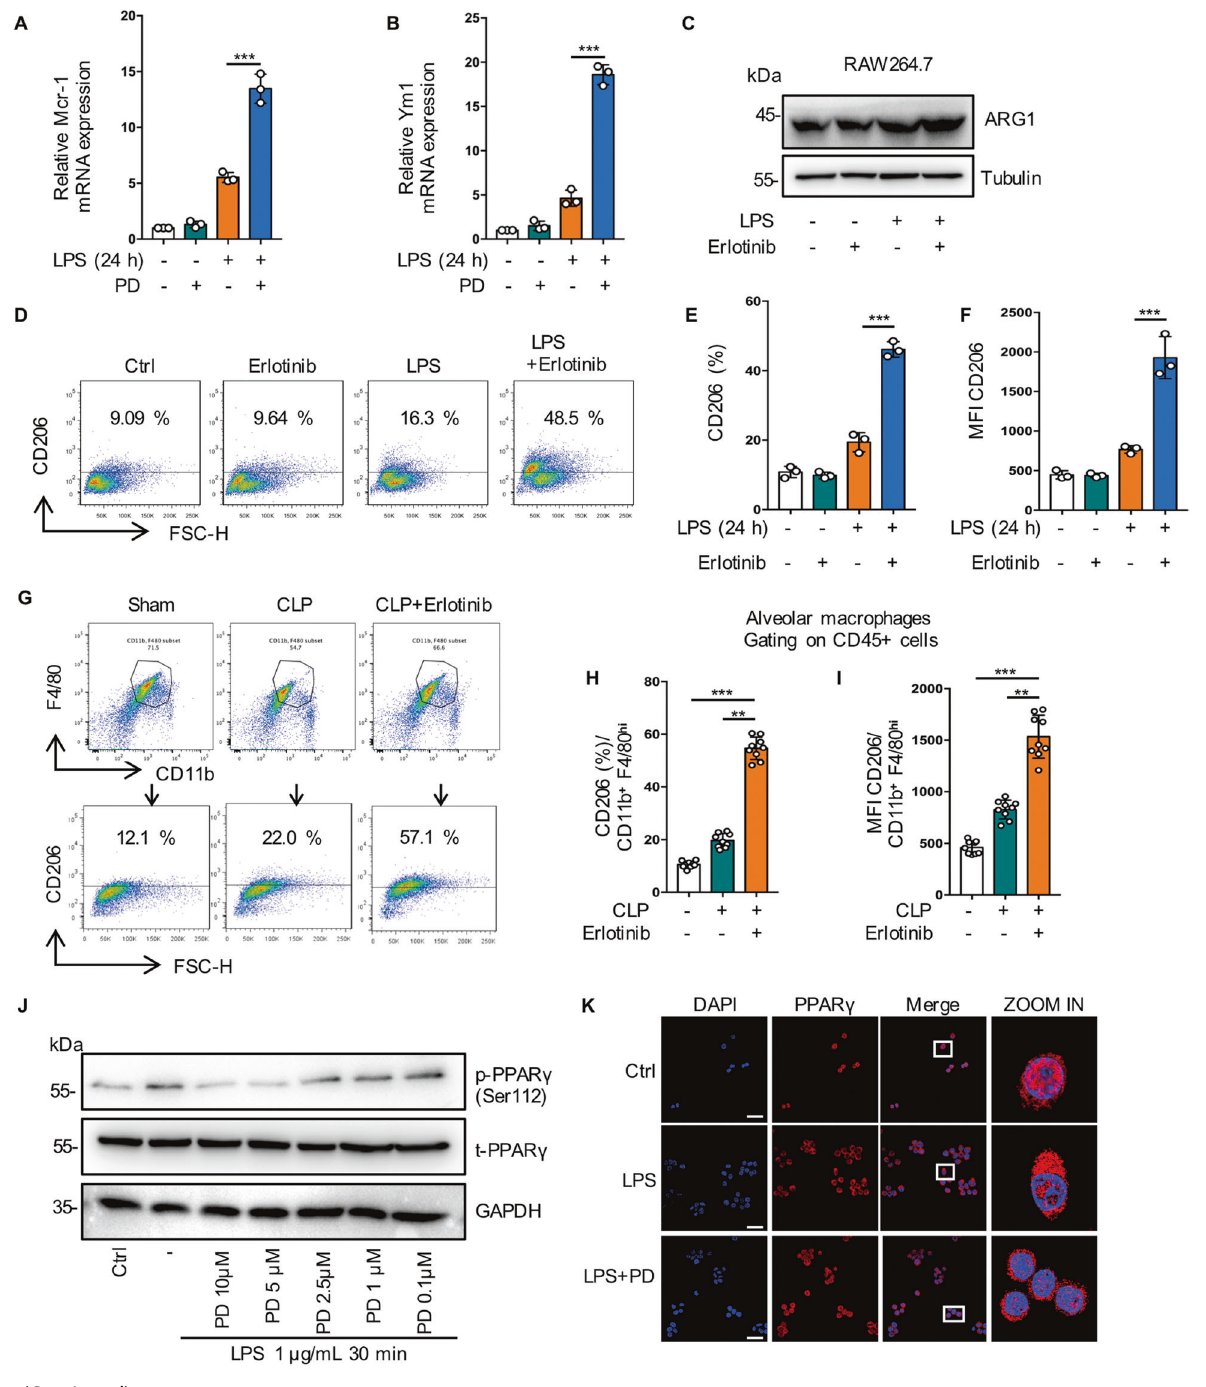
in fl uences sepsis-induced multiple organ injury through meta- bolic